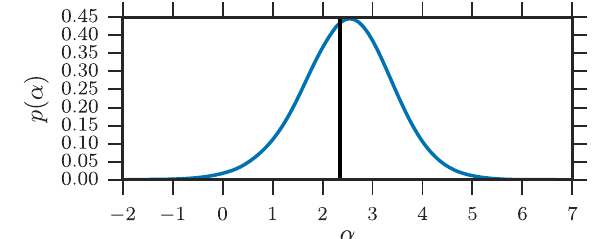
FIG. 12. The posterior distribution for α in Eq. (7) using the inferred masses for our three most significant triggers, GW150914, LVT151012, and GW151226. The vertical line indicates the value of α ¼ 2 . 35 that corresponds to the power- law mass distribution used to infer the rate of BBH coalescence. This value is fully consistent with the posterior, which allows a broad range of possible values with a median and 90% credible interval of α ¼ 2 . 5 þ 1 . 5 − 1 . 6